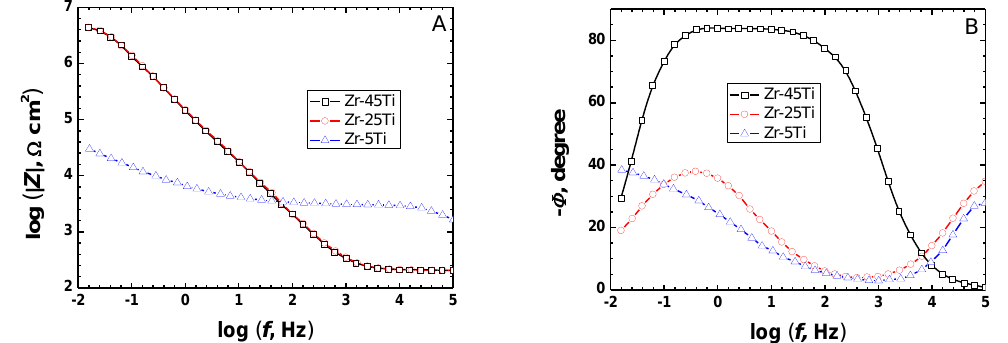
Figure 1. Bode plots acquired by EIS on binary Zr-Ti alloys (oxidized in air at 500 °C for 4 h) after 1-day immersion in PBS at 37 °C. ( A ) Bode-amplitude, and ( B ) Bode-phase diagrams.